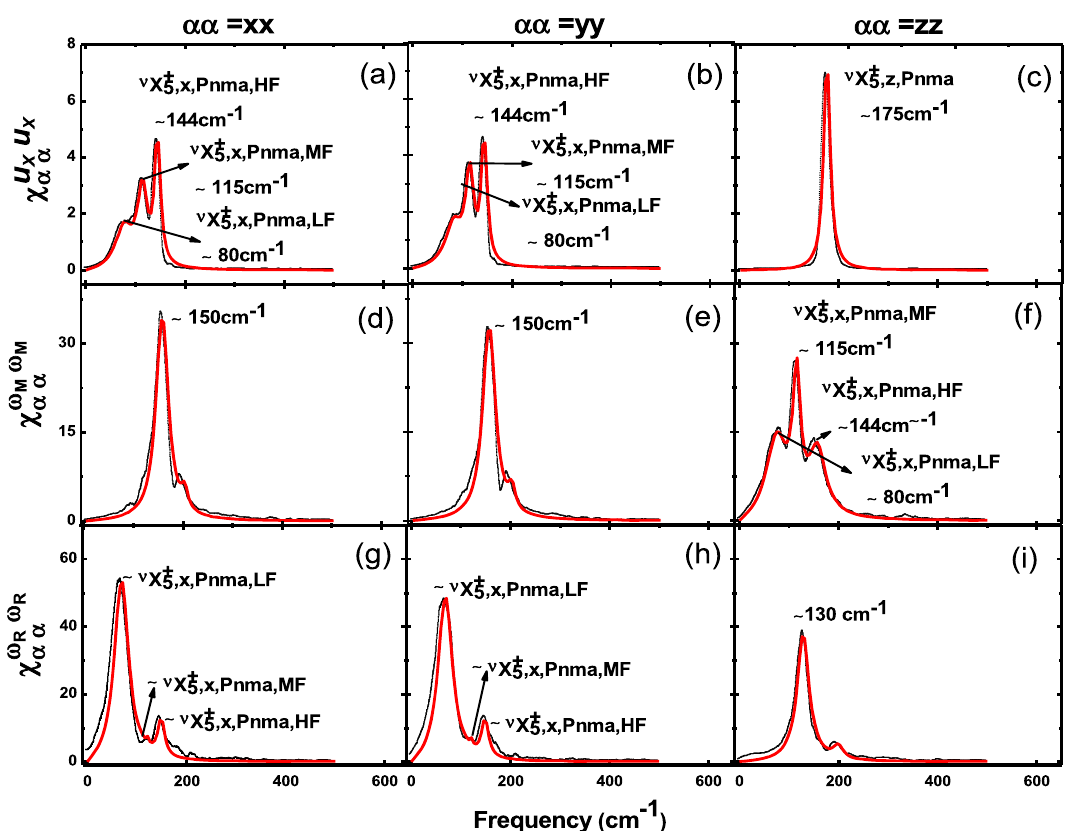
Fig. 4 Same as Fig. 2 but for a temperature of 1040 K (which corresponds to the Pnma